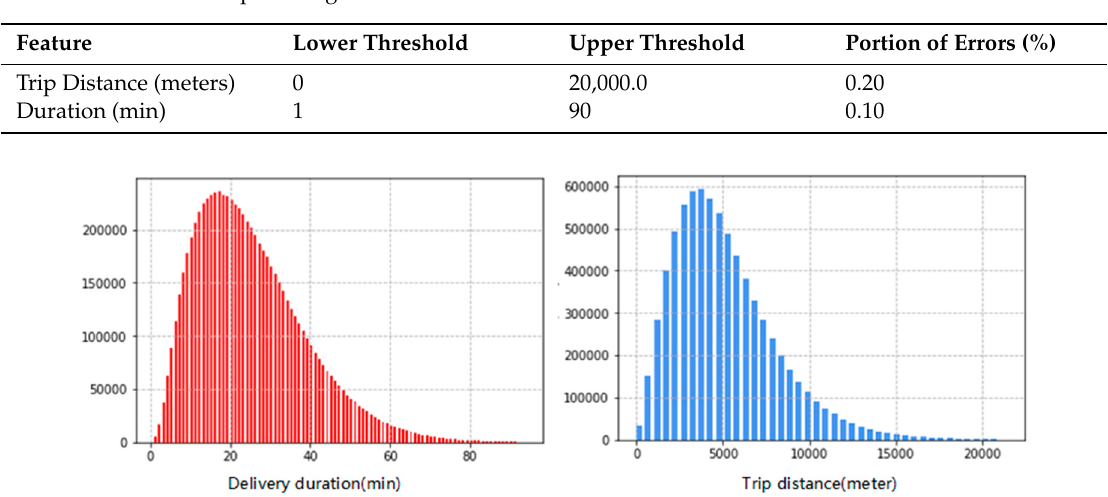
Table 2. The error thresholds that are applied to the trip distance and duration of the dataset. The last column shows the percentage of orders that violate each threshold.